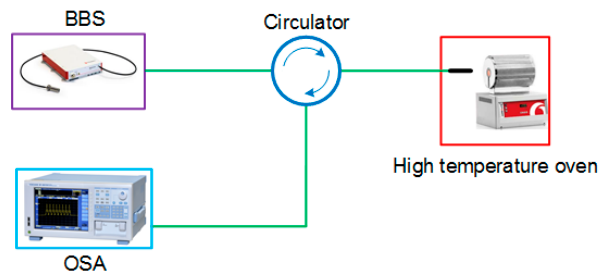
Figure 2. Schematic experimental setup of the tip-FPI sensing system.